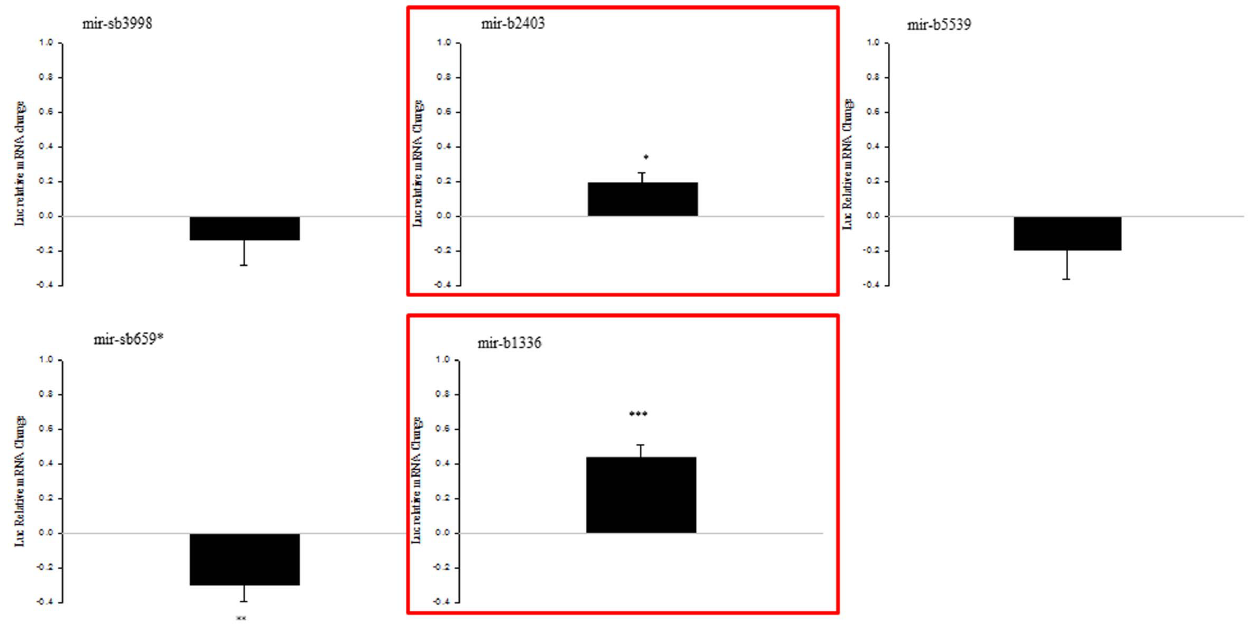
Figure 5. RT-PCR analysis of candidate miRNAs to study the effect on Firefly luciferase mRNA. MiRNA that showed opposite effects in the luciferase assay versus the RT-PCR data presented in Figure 4 and Table3. Two highlighted novel miRNAs that are down-regulated in sALS (mir- b1336 and mir-b2403; red boxes) regulate the expression of NEFL mRNA 3 9 UTR in a manner consistent with that predicted to lead to a decrease in NEFL mRNA. Relative quantitative RT-PCR was performed by transfecting HEK293T cells with pre-miRNAs and a reporter construct expressing Firefly luciferase coupled to the NEFL 3 9 UTR. Data are expressed as relative change compared to let-7a as control and show positive values as up-regulation and negative values as down-regulation. Experiments were performed in triplicate. Results are shown as mean 6 SEM (t-test: p , 0.001=***; p , 0.005=**; p , 0.01=*). No significant change was observed for mir-sb3998 and mir-b5539.